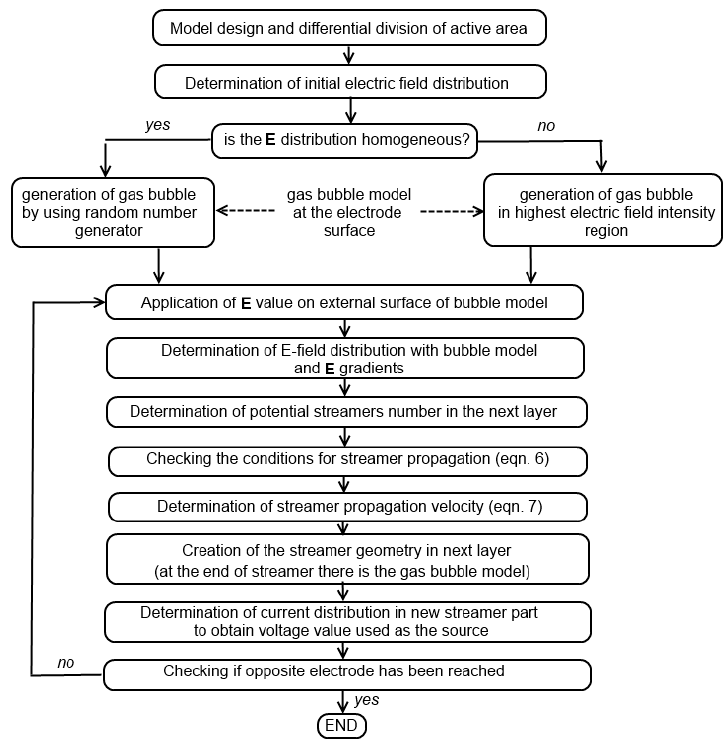
Figure 11. Algorithm for streamer propagation calculation.